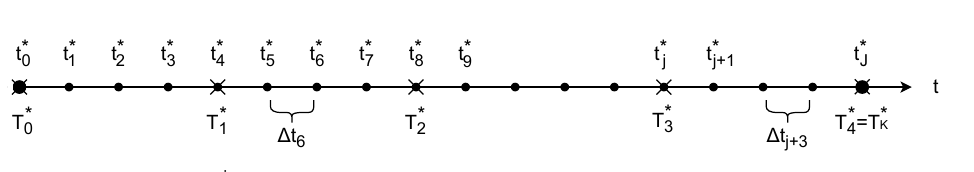
Figure 1. The mesh ω inv (cid:52)